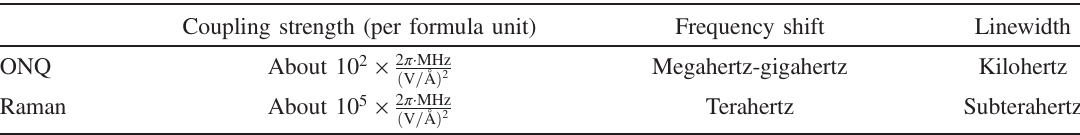
TABLE III. Comparison between ONQ and Raman